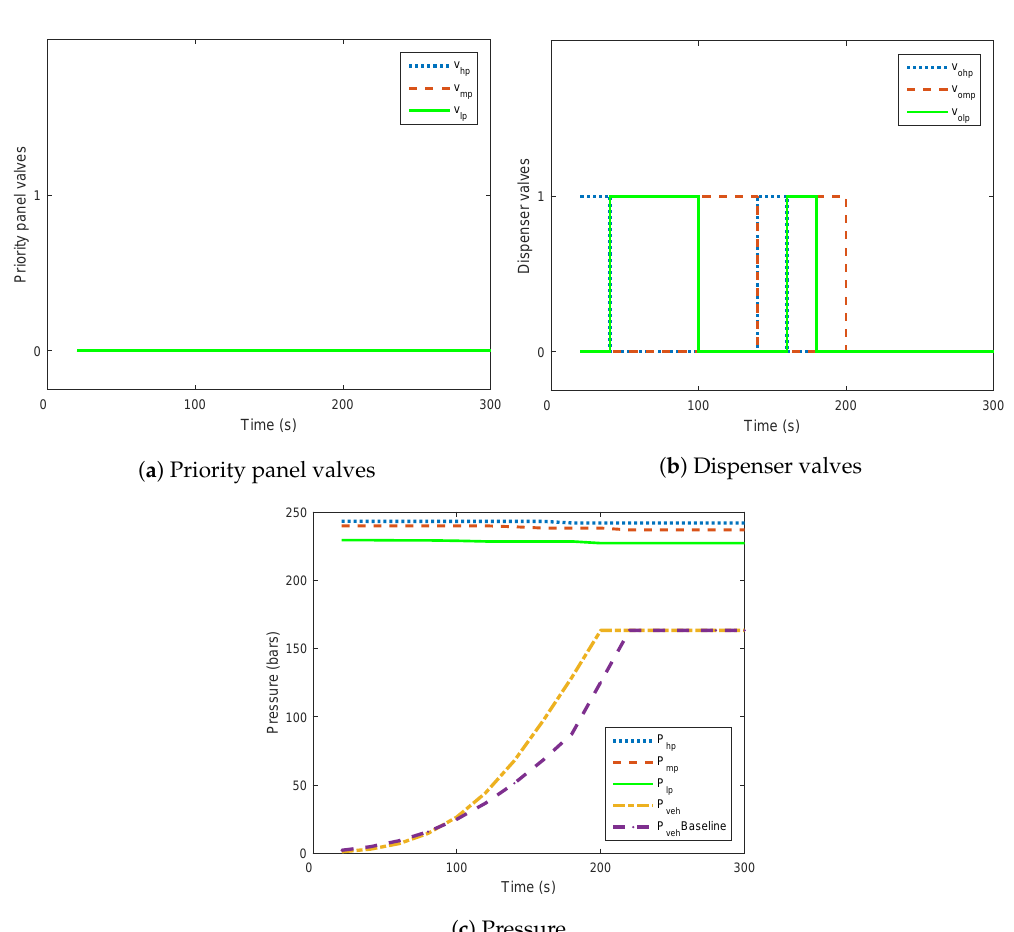
Figure 7. Vehicle filling without the compressor off (fourth vehicle of